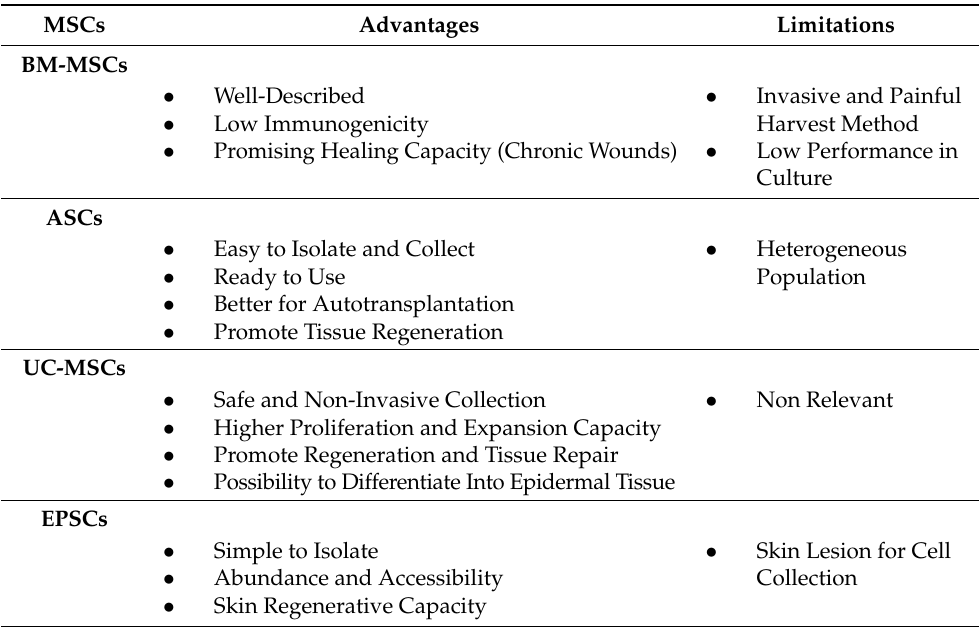
Table 1. Advantages and limitations of different types of